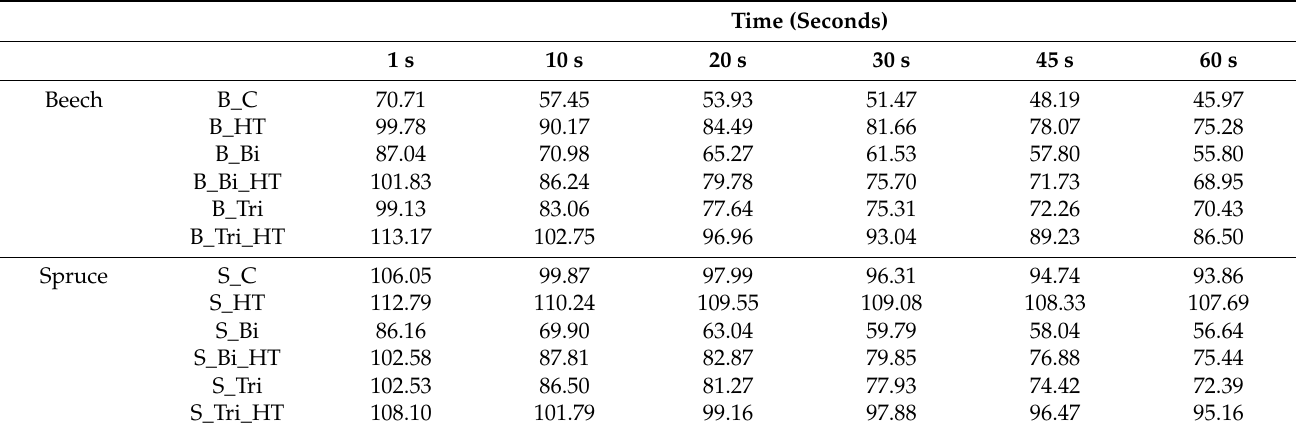
Table 4. Overview of contact angle studies of a water droplet over time. B = beech, S = spruce, Bi = bicine, T = tricine, HT = thermal modification, C = control.